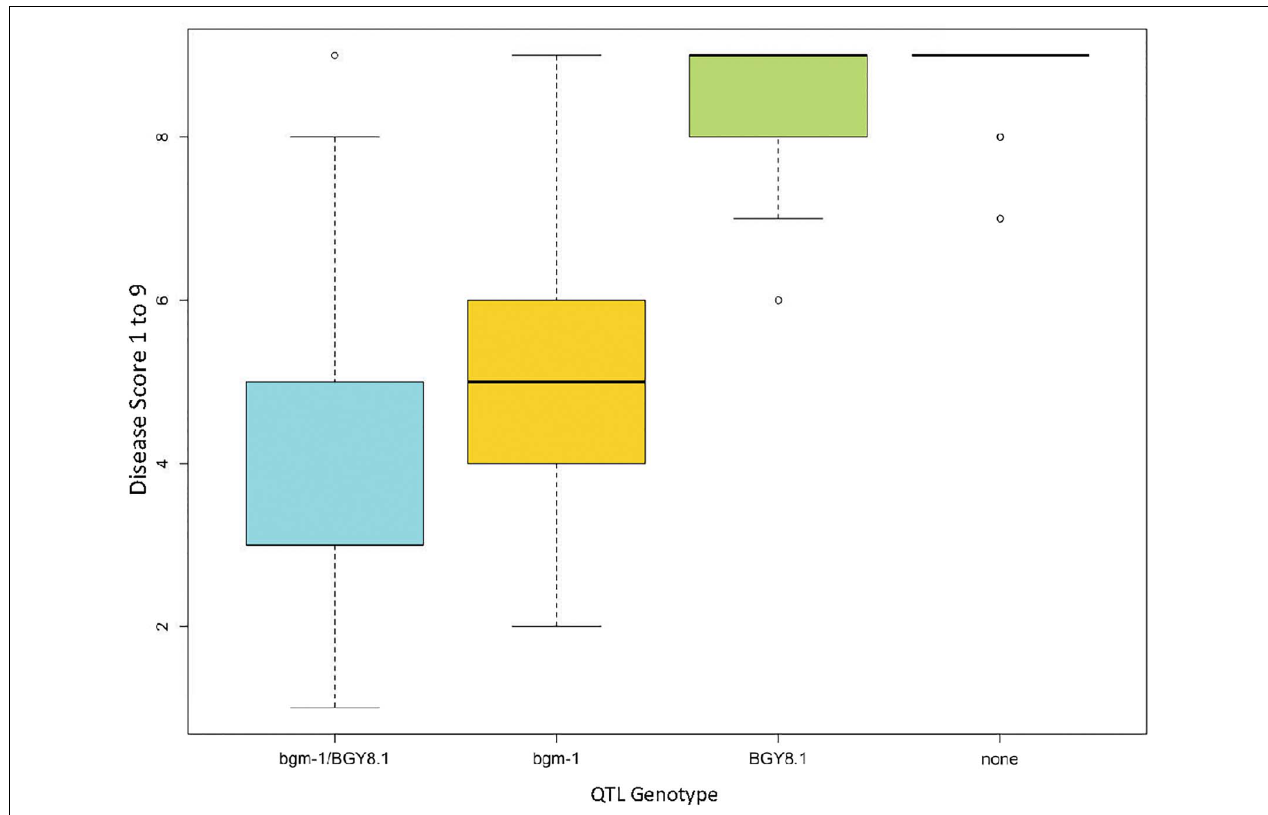
FIGURE 9 | Boxplot showing interaction between bgm-1 (PvNAC1 marker) and BGY8.1 QTL (SNP S08_9202267) in the CIAT population of 412 lines.